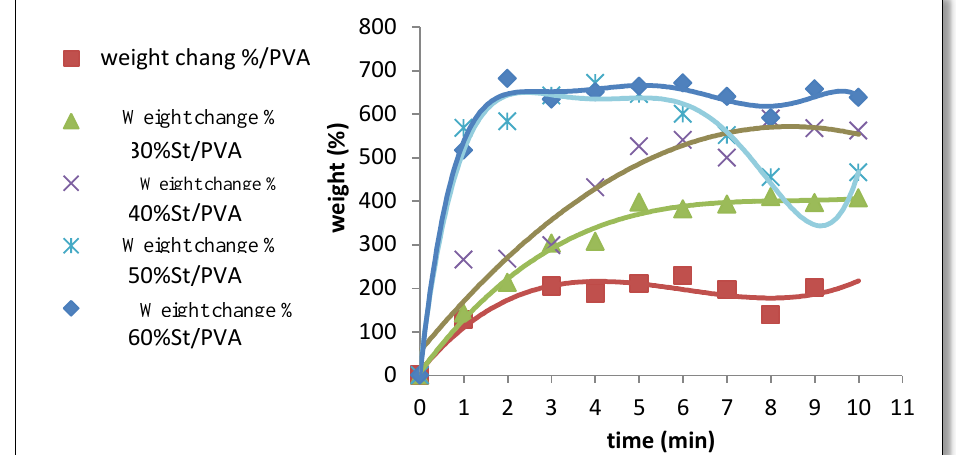
Fig. 1: Water absorption of St /PVA blend film.